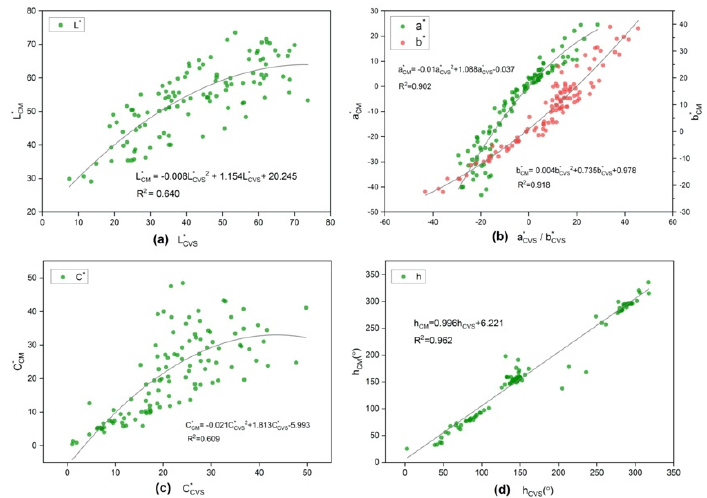
− L ∗ − a ∗ ; ( b ) a ∗ and b ∗ CM − b ∗ CVS ; CM CVS CM CVS